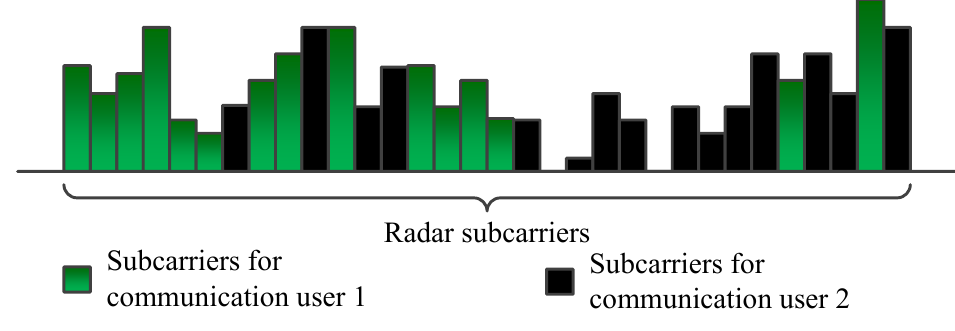
Figure 2. An example of power distribution and subcarrier allocation for the JRC system consisting of two communication